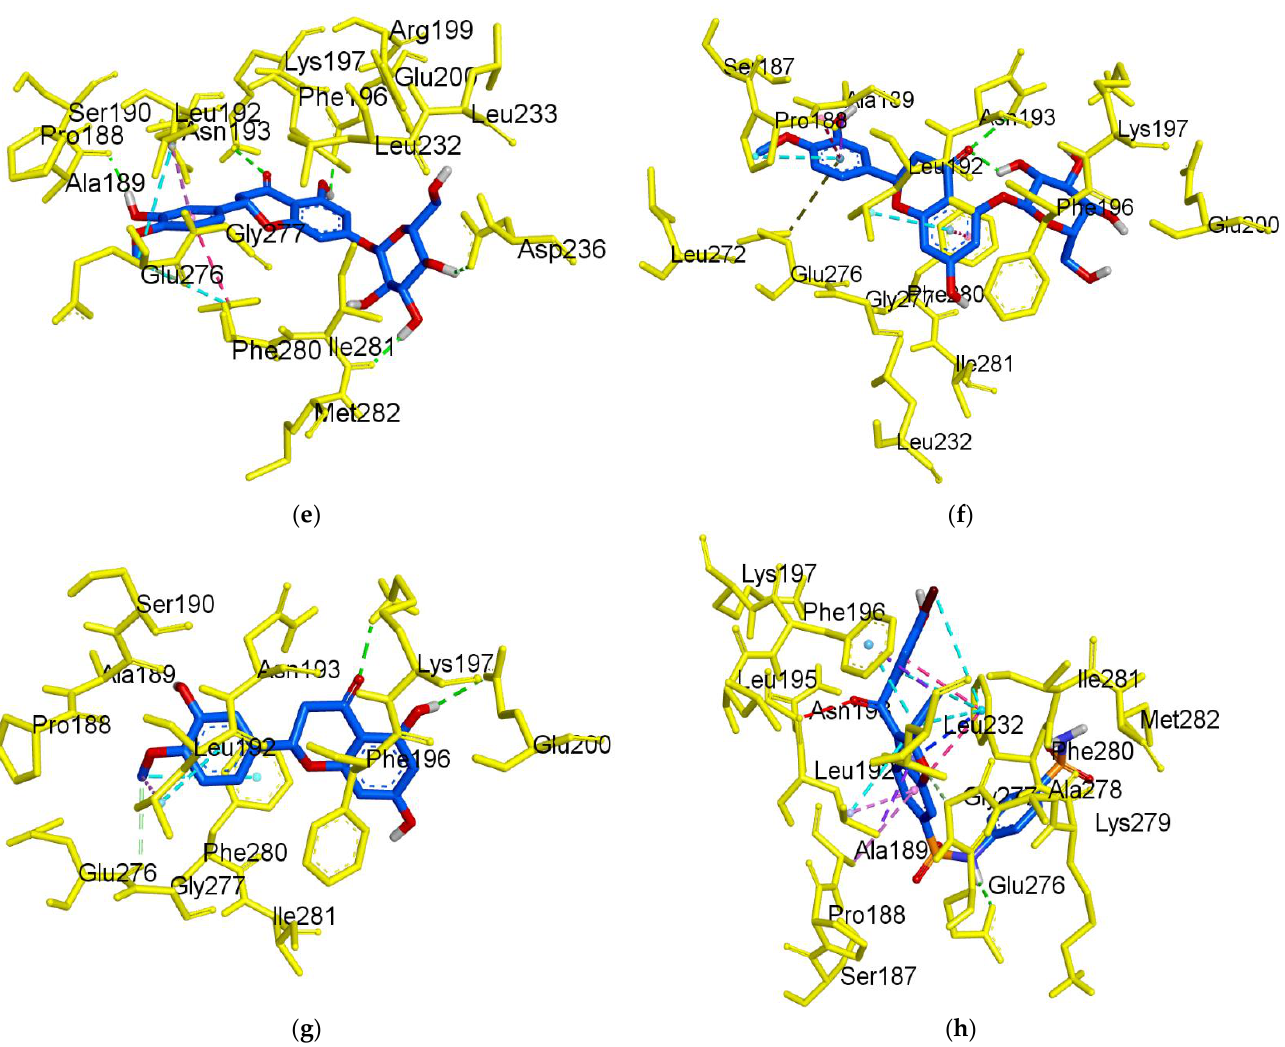
Figure 6. 3D molecular docking models of the catalytic site hesperidin ( a ), neohesperidin ( b ) and compound 23 ( c ), and allosteric site hesperidin ( d ), hesperetin 7- O -glucoside ( e ), hesperetin 5- O -glucoside ( f ), hesperetin ( g ) and compound 2 ( h ) for PTP1B inhibition.